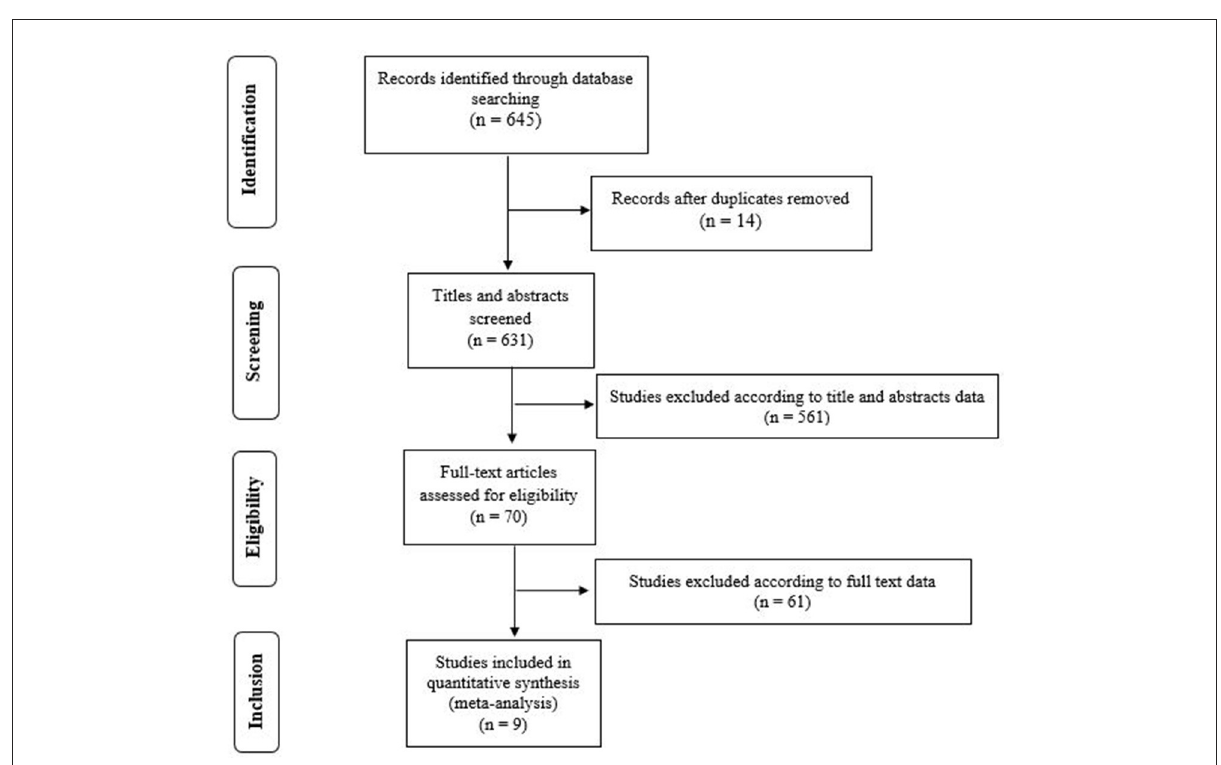
FIGURE1 PRISMA flow diagram summarizing the article selection